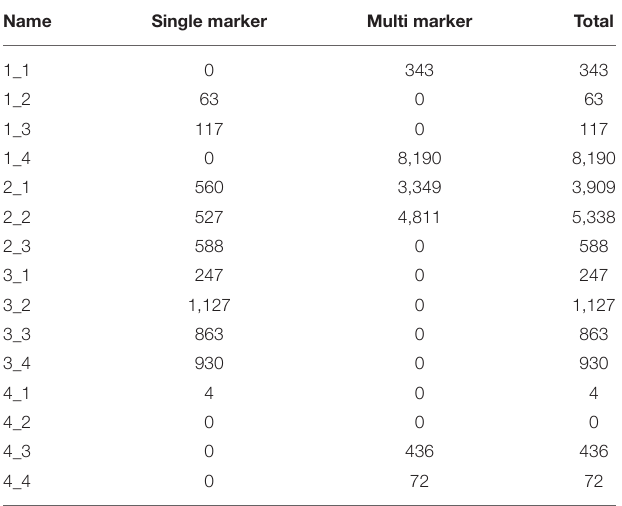
TABLE 2 | Results of marker detection in evaluated videos without preprocessing. TABLE 3 | Averaged results of the numbers of successful marker detections in whole test video groups by dehazing